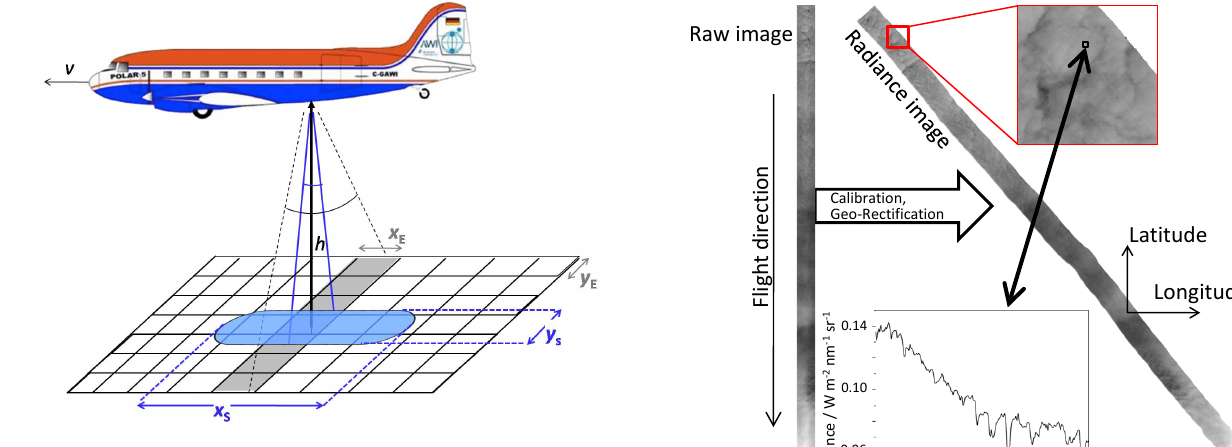
Fig. 1. Viewing geometry for radiances from the Polar-5 aircraft with the field-of-view of the imaging spectrometer AisaEAGLE (black) and of the SMART-Albedometer (blue). Typical dimensions in this study: distance aircraft–cloud h = 2600m, aircraft speed v = 70ms − 1 , width of one AisaEAGLE pixel y E = 3 . 5m, length x E = y E + v · t E = 4 . 2m with the exposure time t E = 10ms, width of in- stantaneous SMART-Albedometer field-of-view y S = 68m, length due to exposure time t S = 0 . 5s: x S = y S + v · t S = 103m.